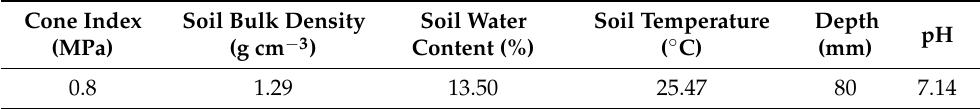
Table 2. Physical and chemical properties of soil in the Acheng experimental field base of Northeast Agricultural University.